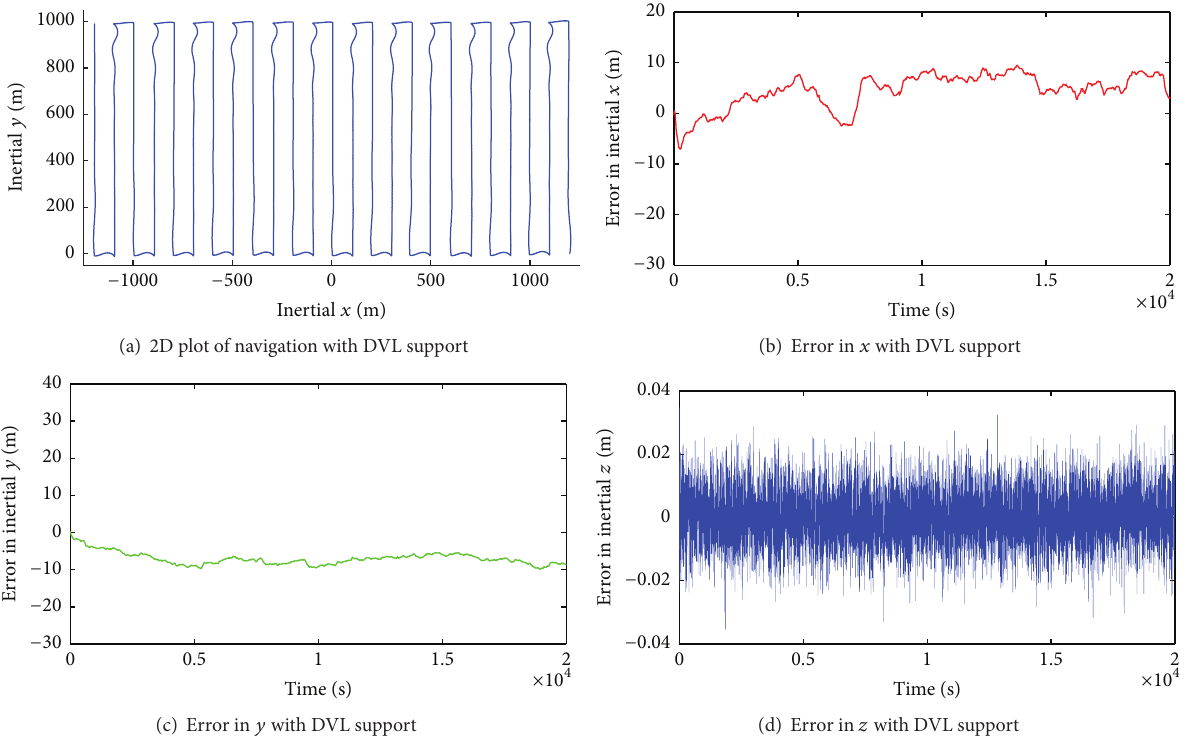
Figure 4: Navigation with DVL support and without 𝑥,𝑦 position fixes.